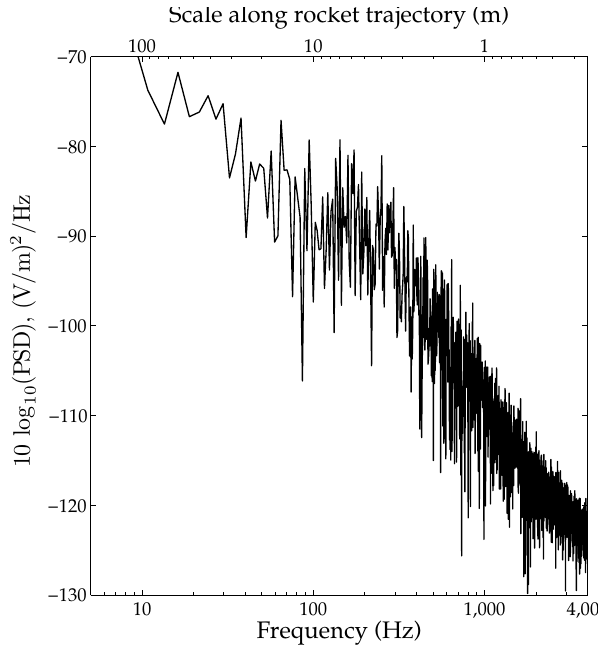
Fig. 9. Power spectral density (PSD) of E 15 within the electron bite-out region. To remove probe shadowing artifacts from the data, spectra were calculated for the regions between the shadowing spikes. The E 15 channel was used because the shadowing spikes occur half as often as in the E 12 data. There is a “knee” in the spec- trum around 250kHz, which corresponds to a spatial scale of